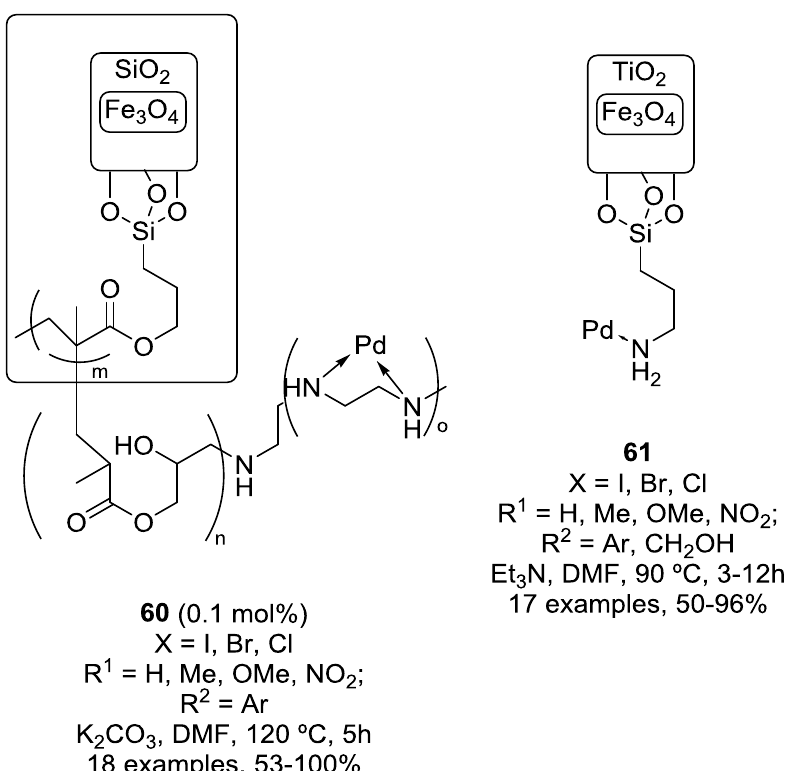
Figure 19. Magnetite coated-grafted palladium catalysts for the Sonogashira reaction. Conditions, substrate scope and yield range (Scheme 2).